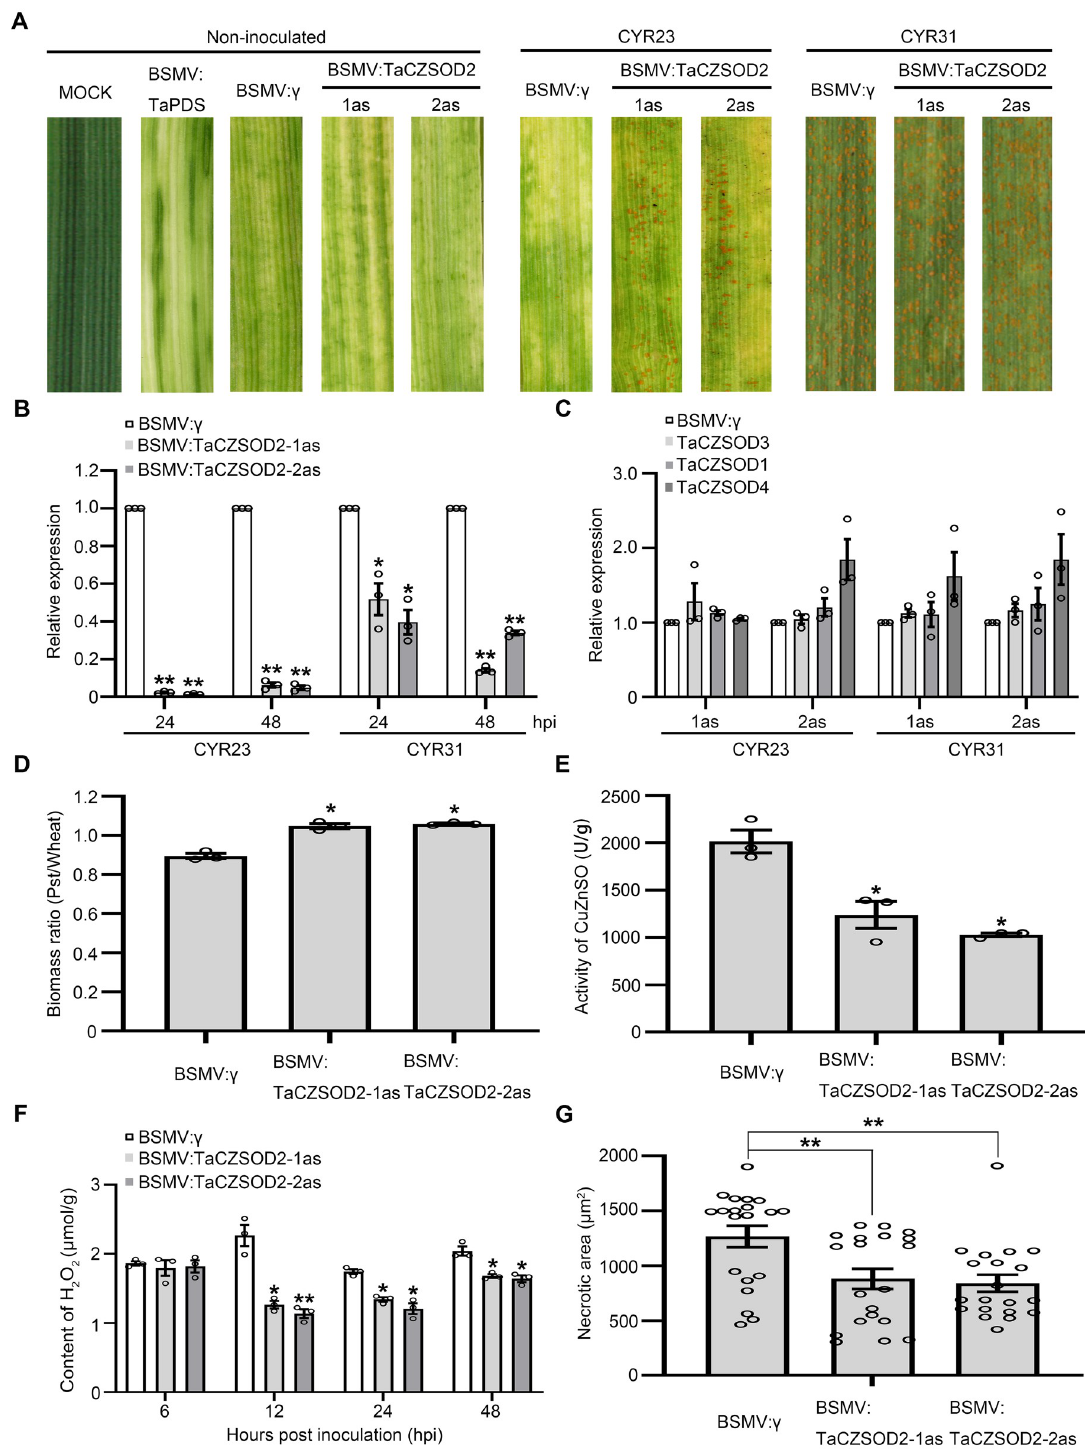
Fig 4. TaCZSOD2 is a positive regulator of wheat immunity. (A) Phenotypes of the fourth leaves of knockdown plants inoculated with Pst race CYR23 and CYR31 at 12 dpi. (B) Relative transcript levels of TaCZSOD2 in TaCZSOD2 -knockdown plants challenged by CYR23 and CYR31. TaEF-1 α was used for normalization. Values represent the means ± SE (n = 3). (C) Relative transcript levels of other TaCZSODs in TaCZSOD2 -knockdown plants challenged by CYR23 at 48 hpi. TaEF-1 α was used for normalization. Values represent the means ± SE (n = 3). (D) After inoculation with CYR23, ratio of fungal to wheat nuclear content using fungal PstEF-1 and wheat TaEF1 α